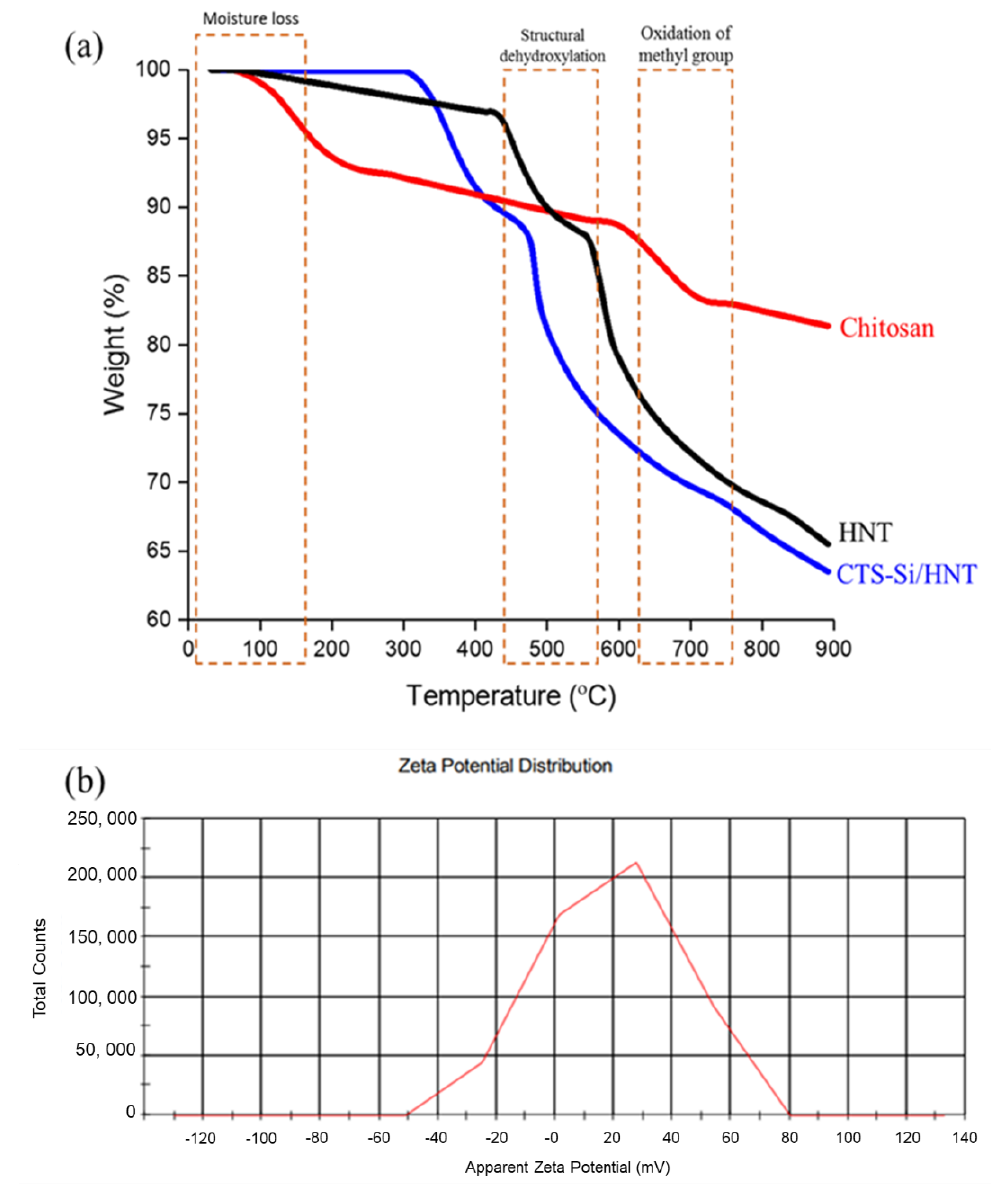
Figure 9. ( a ) TGA analysis of CTS-Si/HNT in comparison with HNT and Chitosan and ( b ) apparent zeta potential of